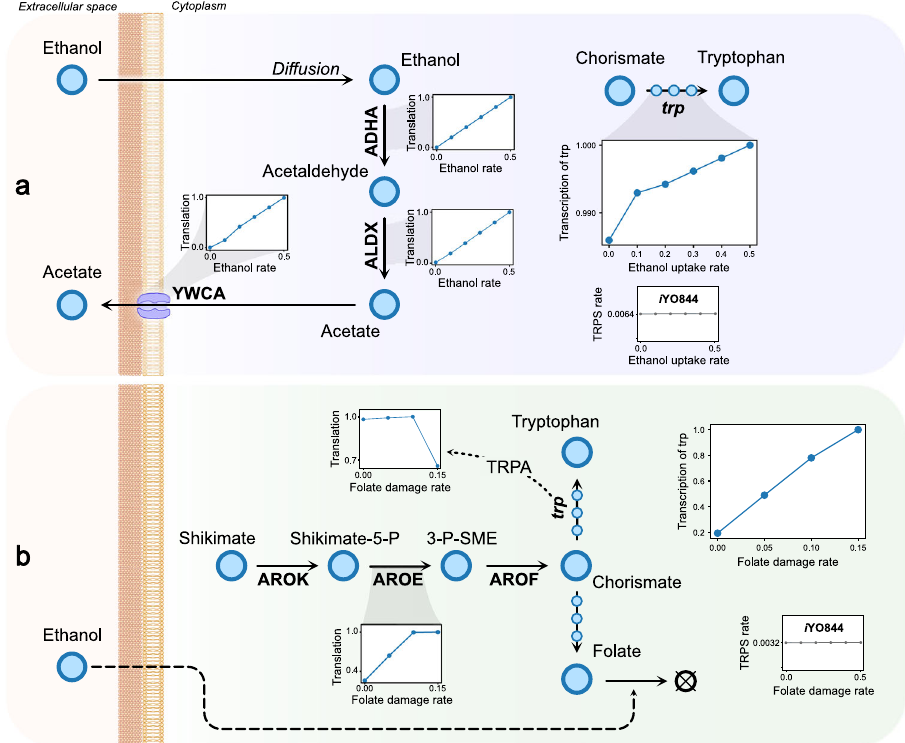
Fig. 2 Upregulation of tryptophan synthesis under ethanol stress. a Hypothesis for the cause of upregulation as predicted by simulations. Results show that ethanol triggers an increased amino acid demand for the synthesis of enzymes necessary for ethanol breakdown, such as adhA and aldX, and the acetate exporter ycwA. The M-model ( i YO844) predictions, the separate graph in gray, show no change in tryptophan synthesis. b Previously reported hypothesis by Rychel et al. as tested by our model. Our simulations suggest that the trp gene aroE has an increased expression to replenish damaged folate, which increments trp transcription. All translation and transcription rates are shown as fractions of the maximum value obtained in the observed range. Ethanol and folate damage rates have units of mmol gDW − 1 h − 1 . Tryptophan synthesis results as predicted by i YO844 are shown in a separate graph in